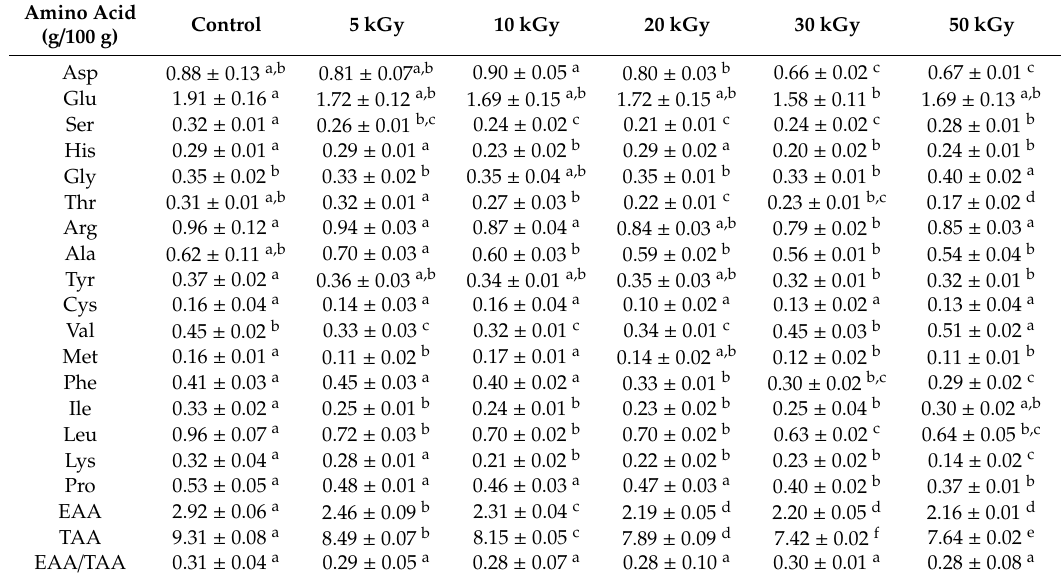
Table 4. Corn amino acid content after EBI treatment.